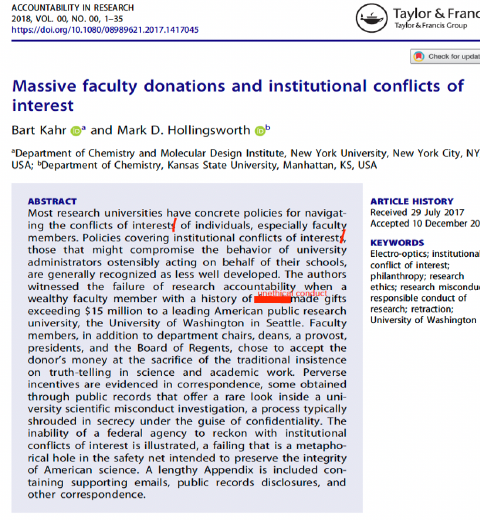
Figure 1. First page of corrected second galley proofs of “Massive Faculty Donations...” Received Jan 25, 2018 and returned corrected Jan 27,